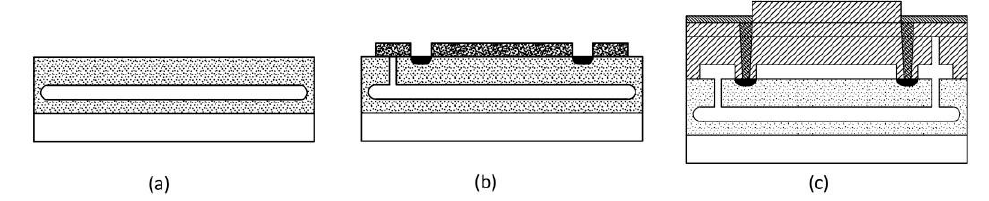
Figure 2. Schematic drawing of device cross section after ( a ) SON-process, ( b ) deposition of sacrificial layer over the first trench and ( c ) suspended structure after sacrificial layer was